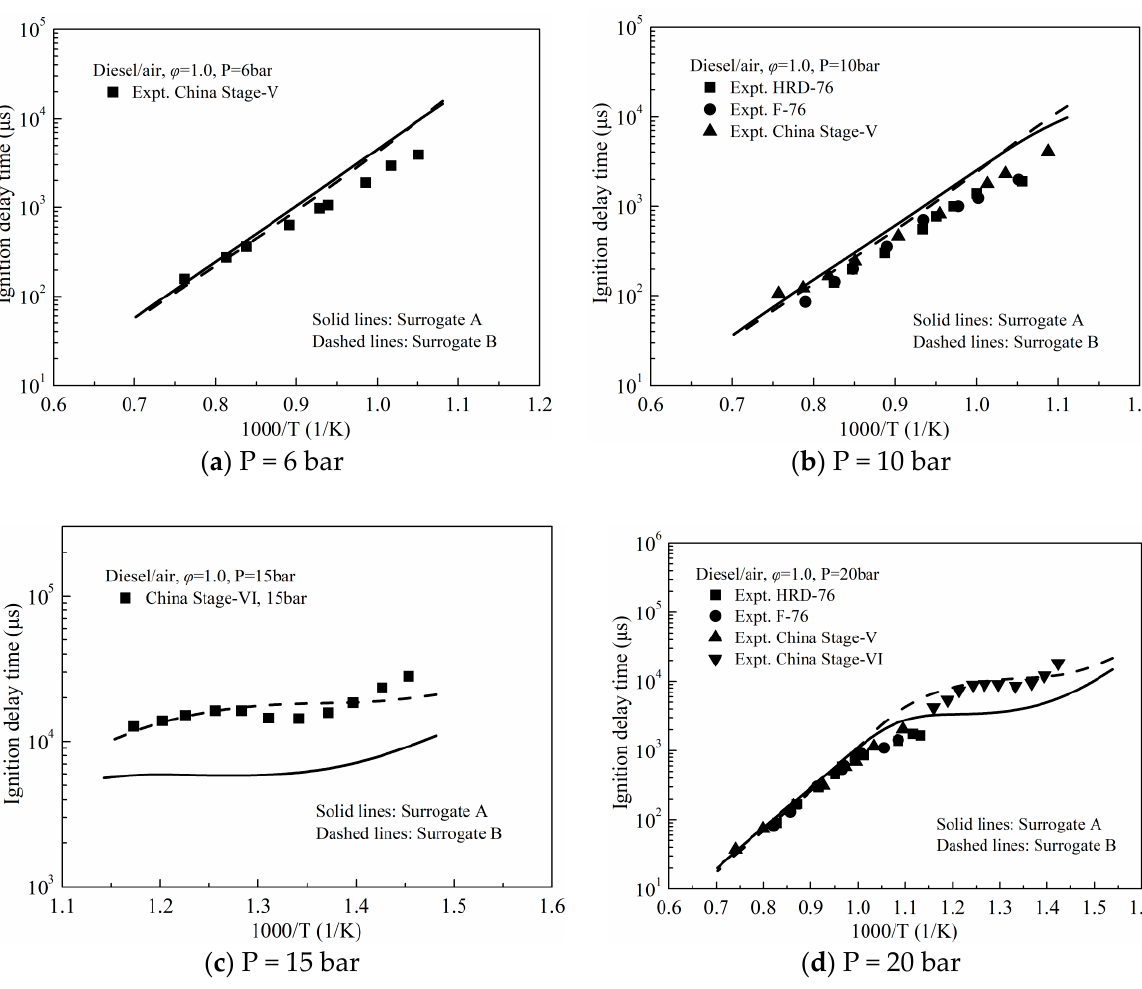
Figure 6. Ignition delay comparisons between simulation and experiment [31–34] for diesel fuel at φ = 1.0. Symbols: experiment; lines: simulation.